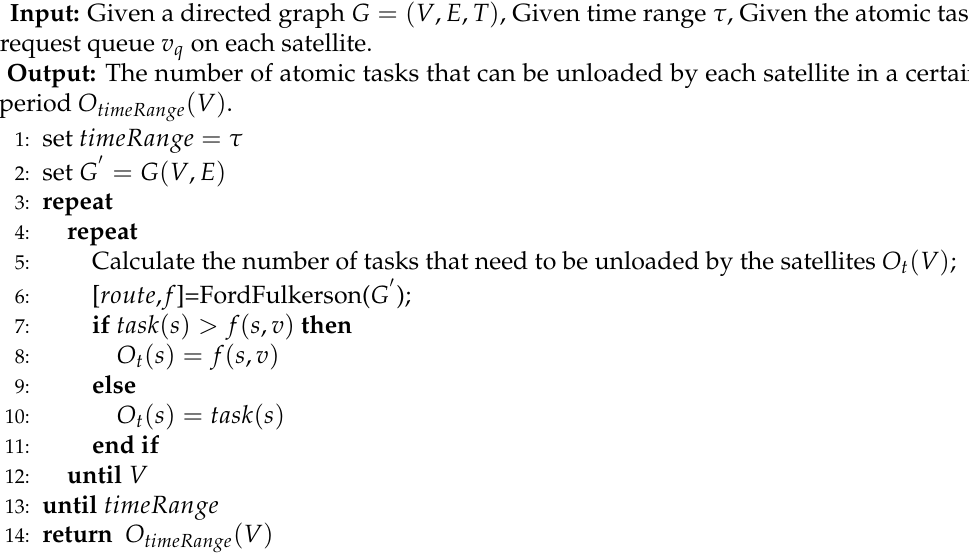
Algorithm 1 Optimal allocation of task offloading